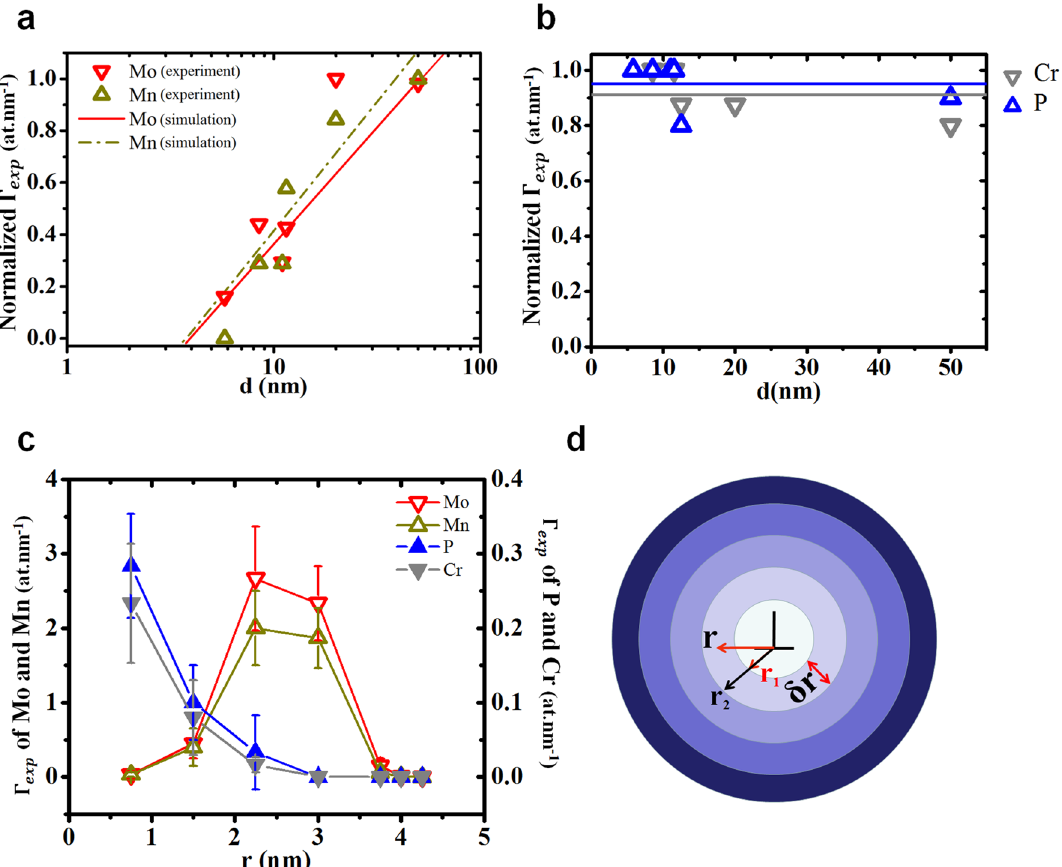
Figure 3. Experimental measurements of single element segregation at edge-dislocations forming a regular 1D array characterized by an inter-dislocation distance d . ( a ) Normalized Excess Number ( Ŵ exp ) variations at the dislocation versus d for Mo (down triangles) and Mn (up triangles) atoms compared to simulations (dotted line for Mo and solid line for Mn). ( b ) Normalized Excess Number ( Ŵ exp ) variations at the dislocation versus d for P (up triangles) and Cr (down triangles) atoms. ( c ) Variations of the dislocation Ŵ exp of Mo (open down triangles), Mn (open up triangles), P (solid up triangles), and Cr (solid down triangles) atoms versus the radius r corresponding to the distance from the dislocation line in the cylindrical geometry, measured in a dislocation array with d = 8.5 nm. ( d ) Schematic showing the top view of the concentric cylinder trenches used to determine the concentration-versus-radius profiles in APT volumes around each dislocation line ( ⊥ low-angle GB, in order to determine the variations of the Ŵ T exp as a function of the average distance d measured between the dislocations in each GB. The values of the Ŵ T exp are given in the last column of Tab. 1 versus the distance d . The Fig. 2c presents the experimental variation of the Ŵ T exp versus d . As predicted by Eq. (6), these variations can be fit with a logarithmic law (dashed lines in Fig. 2c). The Ŵ T exp -vs-radius profiles measured for different inter-distances 8.5 ≤ d ≤ 50 nm (Fig. 2d) show different segregation behaviors between the dislocation core and its surroundings. The total impurity segregation level close to the dislocation core (smaller radius in Fig. 2d) is lower than that further away from the core, and exhibits a constant segregation level independent of d . The impurity segregation level variations versus d occur exclusively out of the dislocation core, in the dislocation surroundings up to r ~ 4 nm. In this region, impurity segregation forms atom atmospheres (or clouds) expected to be driven by the elastic field surrounding the dislocation line. Consequently, in this region the segregation level increases with d following a logarithmic law as predicted by Eq. (6), as the segregation level is constant close to the dislocation core. As presented in Fig. 2c,d, similar measurements concerning the collective segregation of the different solutes were performed for independent solute elements. The excess number ( Ŵ exp ) measured for each individual impurity versus d is given in Tab. 1. The different segregation behaviors observed between the core and the surroundings are actually linked to the nature of the segregating element. For example, the segregation of Mo and Mn atoms on the dislocations varies with the distance between dislocations as proposed by Eq. (6) (Fig. 3a), while the segregation of P and Cr atoms is constant and independent of d (Fig. 3b). These observations, compared to the results presented in Fig. 2c,d, lead to the conclusion that P and Cr atoms occupy the dislocation core, while Mo and Mn atoms form Cottrell’s atmospheres surrounding the dislocation line. In order to confirm this hypothesis, the Ŵ exp -vs-radius profiles of these four elements were determined using the same technique as for the Ŵ T exp -vs-radius profiles presented in Fig. 2d, based on concentration-vs-radius profiles